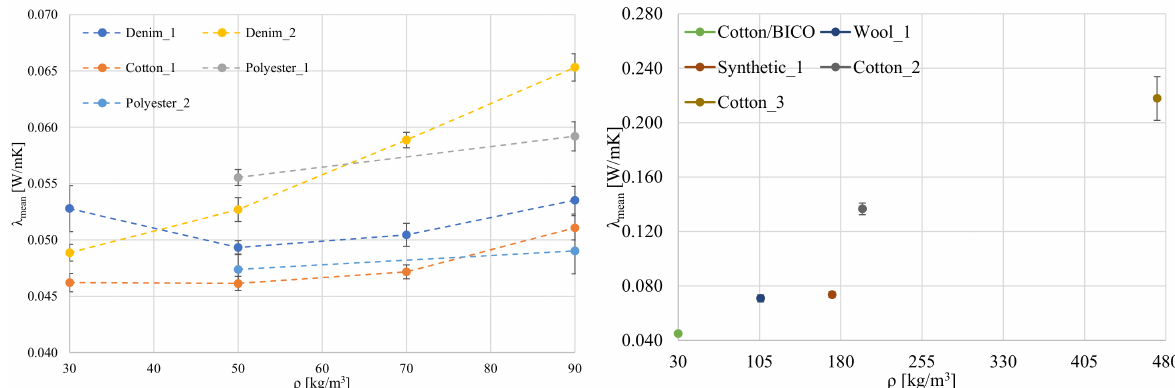
Figure 3. Thermal conductivity of the tested loose (left) and composite (right)